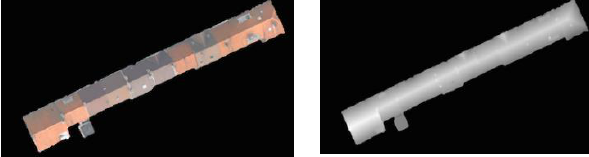
Figure 5. Building area extraction form a) optic imagery b)LiDAR data